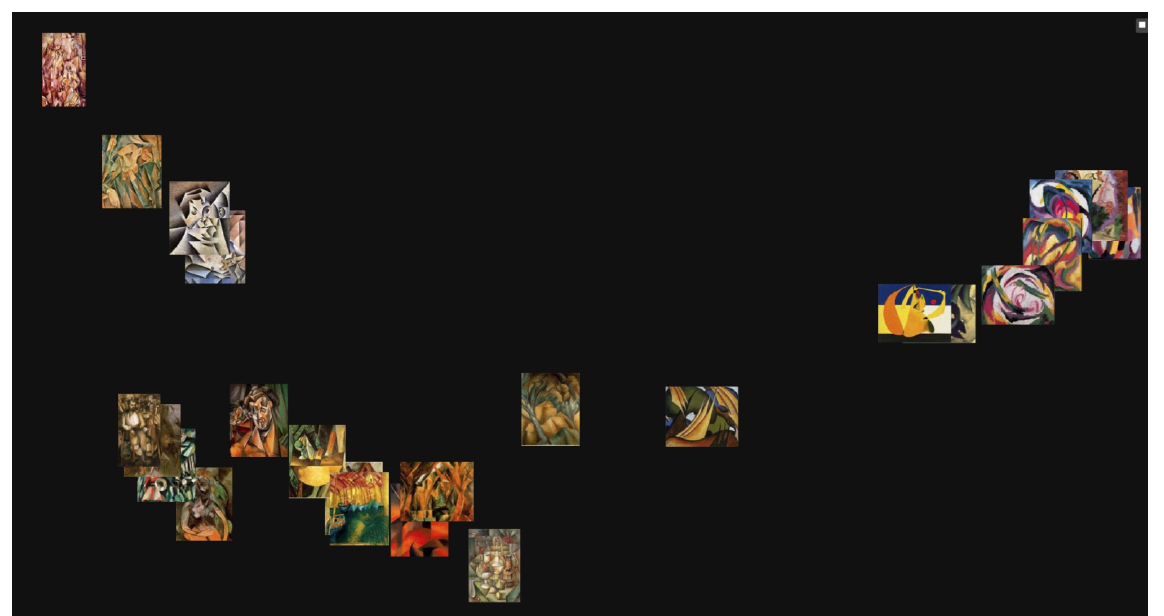
Figure 13. Section of a two − dimensional projection of image vector space (Barr X Inception CNN). Available on: https://digital-narratives.versae.es/#. (accessed on 28 July 2022) (screenshot).